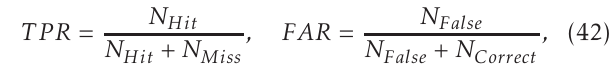
Figure 3. Normalized MSE of spectrum estimation